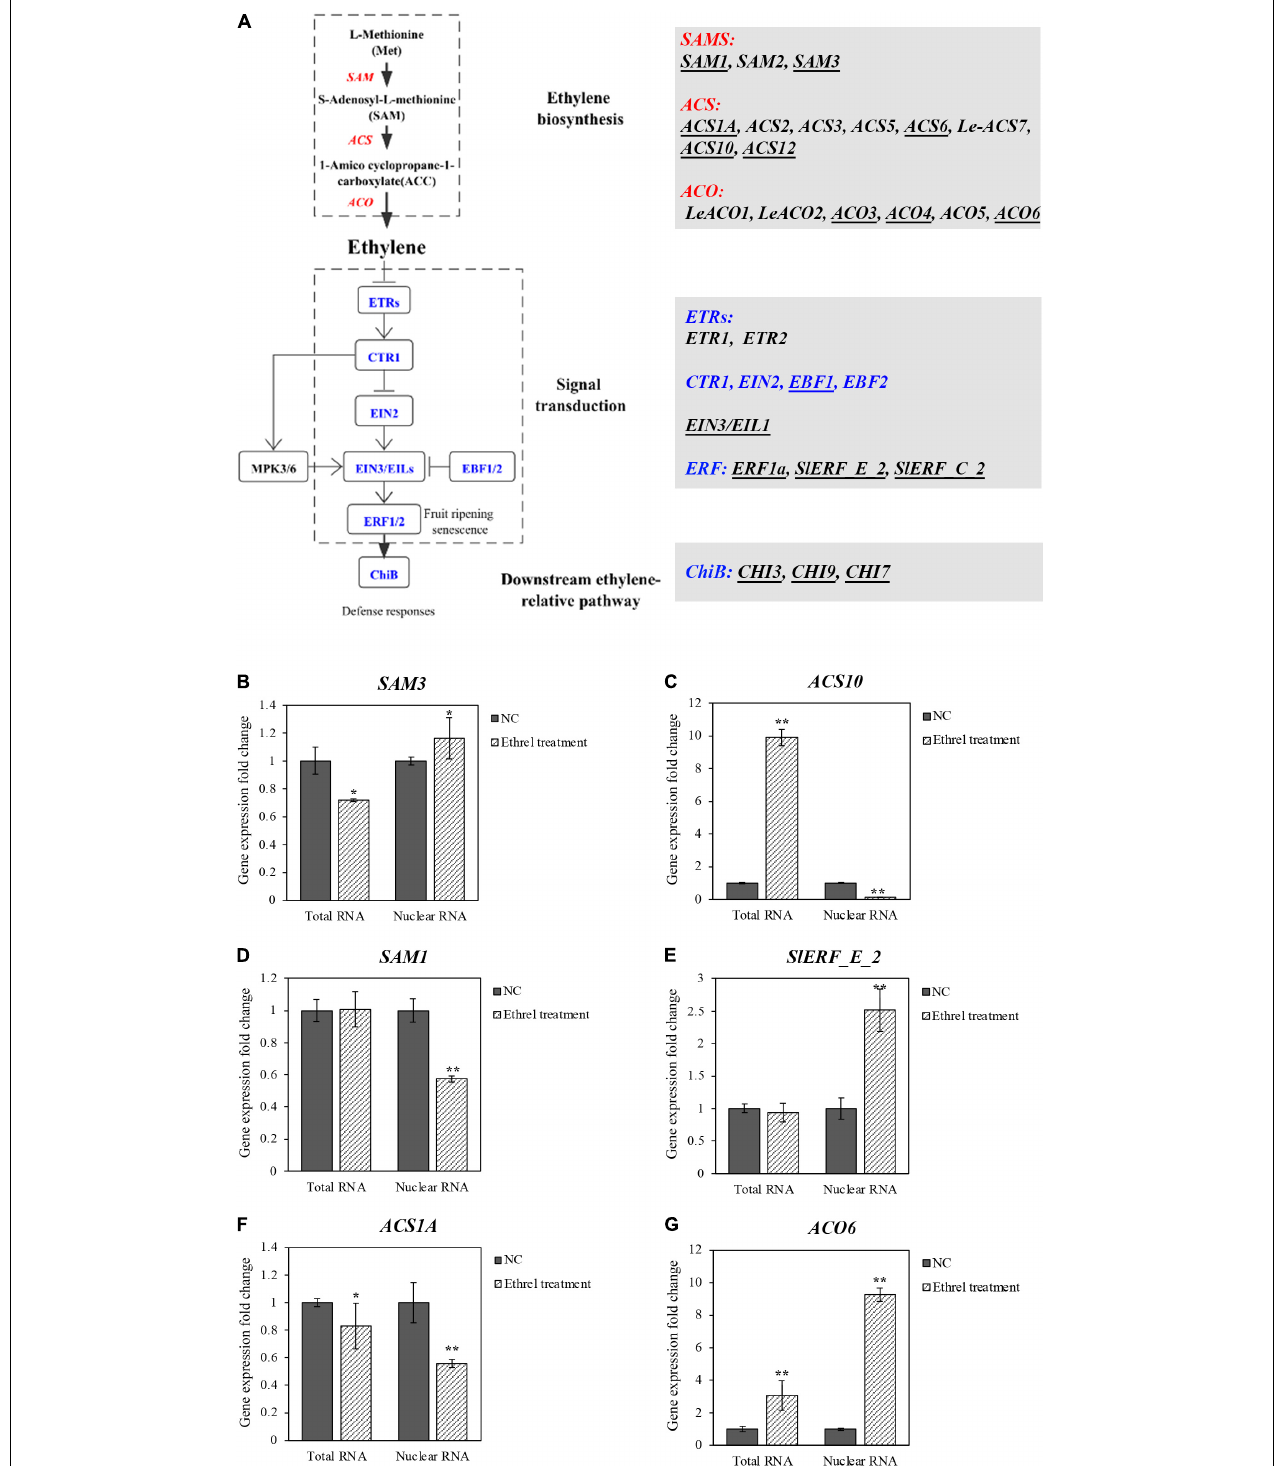
FIGURE 6 | Relative expression of ethylene-related genes in total RNA and nuclear RNA from leaves of GW2 lines with ethylene treatment. (A) Sketch map of ethylene synthesis and signal transduction pathways; all genes in these pathways were listed. Essential genes with relatively higher expression value (RPKM; Tomato Genome, 2012) in tomato leaves were underlined, which is shown as reverse changes (B,C), different changes (D,E), alike (F,G) in comparison with total RNA and nuclear RNA. Group of GW2 without ethephon treatment is used as a NC. Asterisks indicate significant differences (* p < 0.05, ** p < 0.01) in comparison with